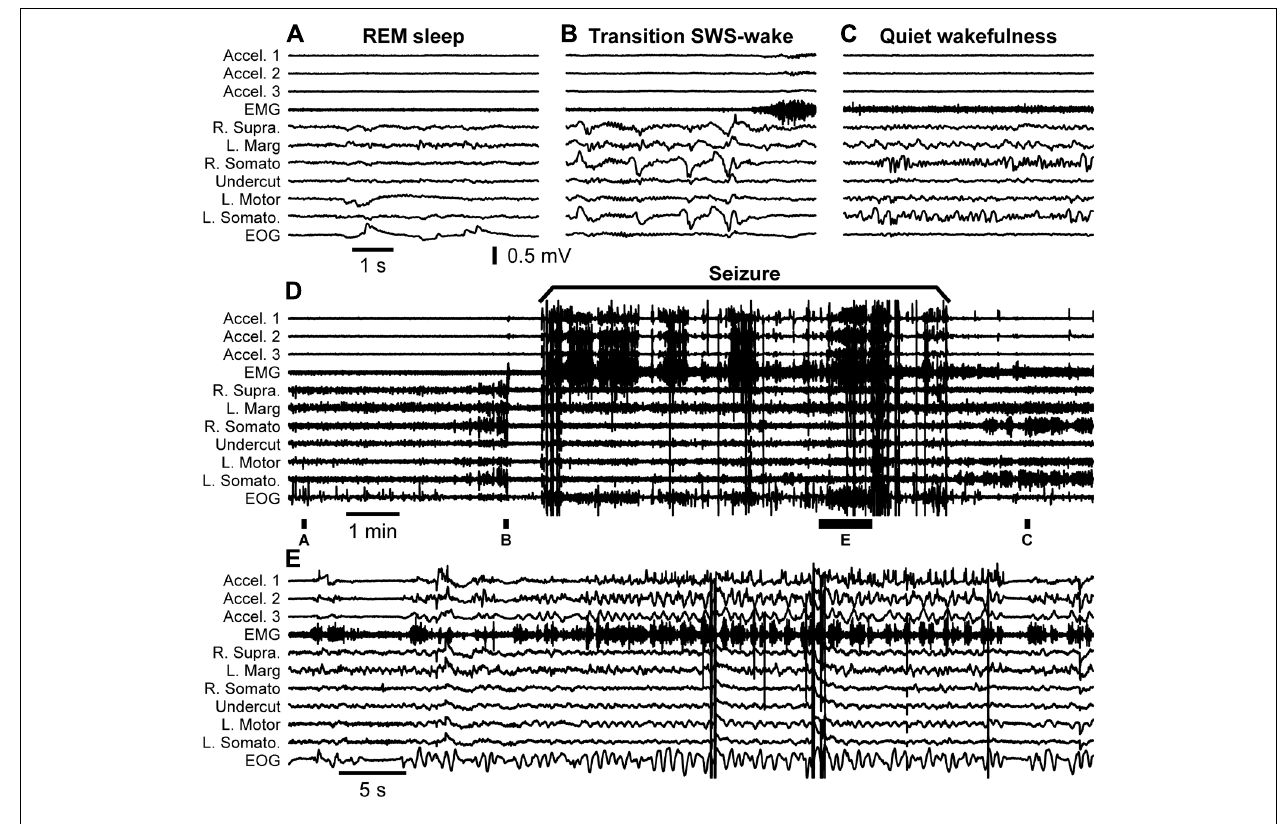
FIGURE 6 | Spontaneous seizure recorded in a cat 3.5 months after partial deafferentation of the suprasylvian gyrus. The seizure occurred during quiet wakefulness.The full extent of seizure as well as pre and